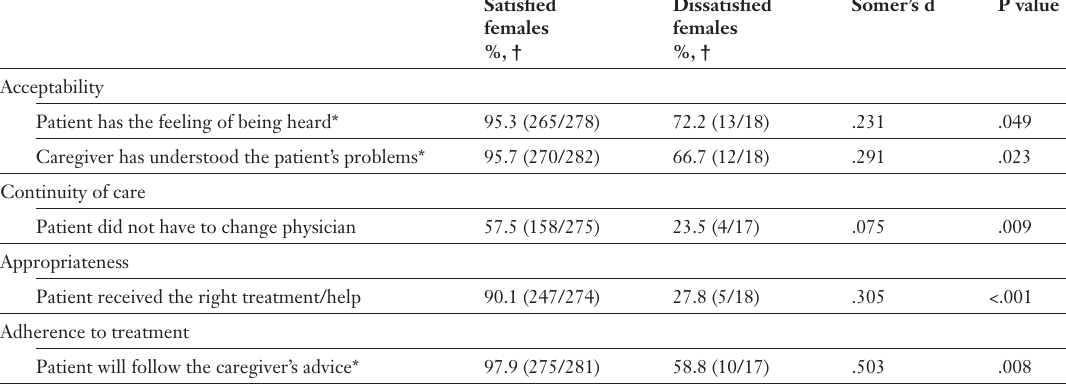
Statistically signifi- cant explanatory factors of female patients’